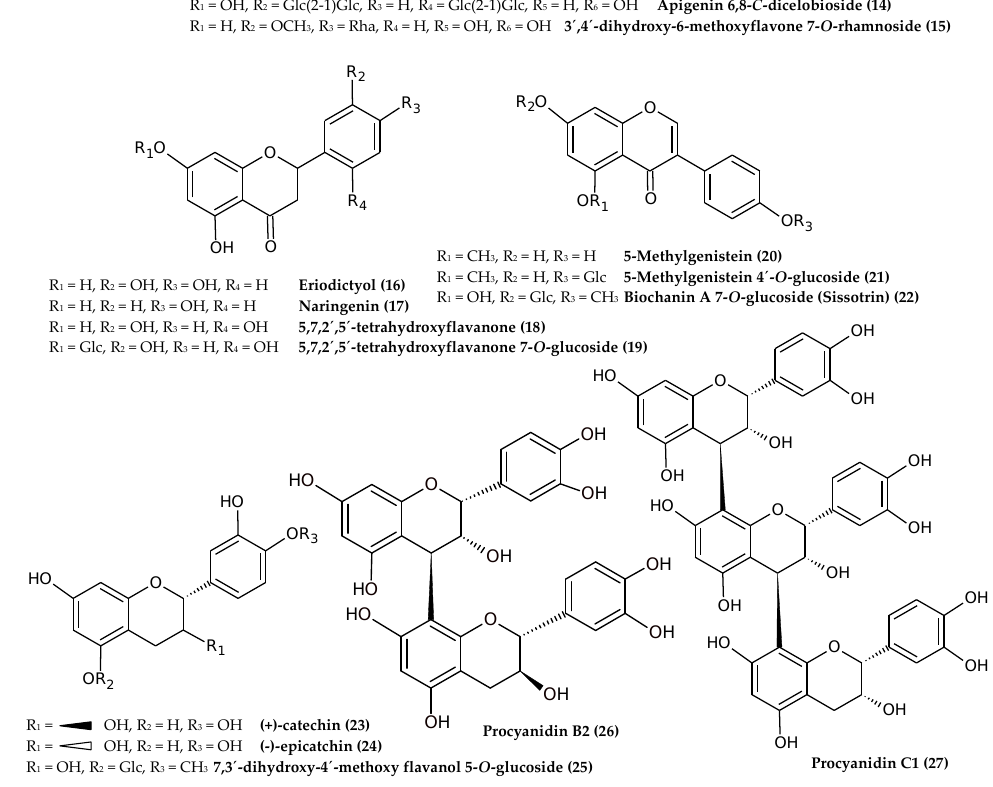
Figure 3. The chemical structures of flavonoids and procyanidins isolated from the genus Cotoneaster. The polyphenols, with the largest contribution of flavonoids and procyanidins, have been quantified by HPLC-PDA and Folin-Ciocalteu (FC) methods in the leaves, fruits, and leafy twigs of various Cotoneaster species. As shown in Table 1, the highest polyphenol content was recorded for leaf samples (FC: 51.7–154.3 mg gallic acid equivalents (GAE) / g of leaf dry weight), especially for the leaves of C. bullatus and C. zabelii (FC: 154.3 and 124.9 mg GAE / g). These leaf samples were classified as polyphenol-rich plant material, with a level comparable to or even higher than those observed for other polyphenol abundant Rosaceae leaves, i.e., Rosa canina , Aronia melanocarpa and Ribes nigrum [19]. Due to the desired therapeutic value, this phenolic content might be further increased in dry methanol-water (7:3, v / v ) extracts obtained from Cotoneaster leaves, reaching a level above 300 mg GAE / g of extract dry weight (Table 1) [20]. In other Cotoneaster plant parts, the level of phenolics is much lower, and maximally reached 113.6 and 49.5 mg GAE / g in the respective bark and fruits of C. integerrimus